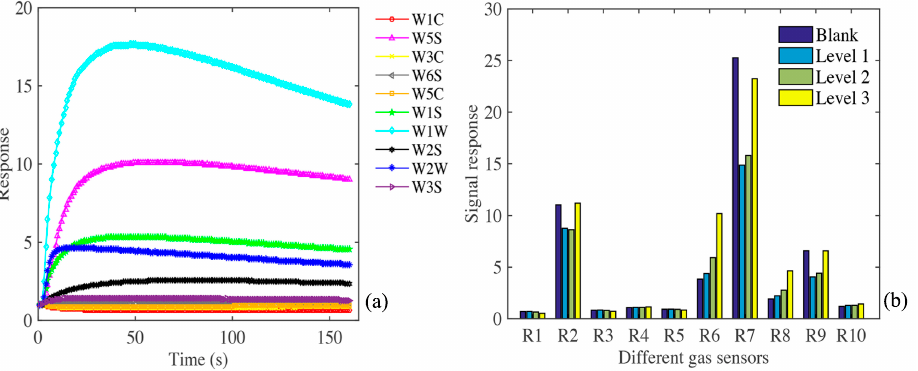
Figure 2. ( a ) Data of each sensor of a single corrupt apple; ( b ) response signals of various sensors to apple gases with di ff erent degrees of apple gases with different degrees of corruption.